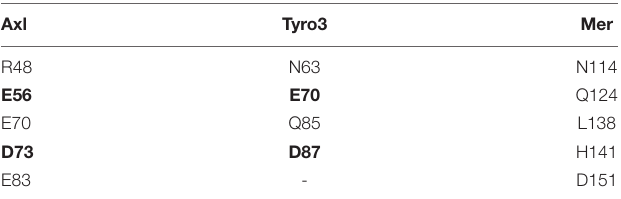
TABLE 1 | Positional sequence comparison of R48, E56, E70, D73, E83. E56 and D73 are conserved in both Axl and Tyro3 (shown in bold). Axl Tyro3 Mer